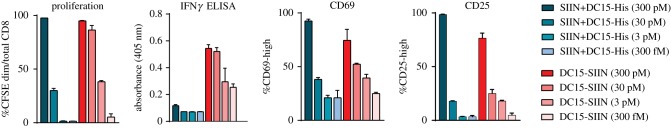
DC15 targeting increases antigen-presentation in vitro. B cells were isolated from mouse spleen by negative selection using CD43 magnetic beads and cultured with agonistic anti-CD40 for 3 days to induce B-cell blasts for use as APCs. APCs were pulsed for 30 min with the indicated concentrations of DC15 either admixed with (blue bars) or directly conjugated to SIINFEKL peptide (red bars). APCs were then washed to remove any unbound or non-internalized antigen and cocultured with CFSE-labelled OT-I T cells. Proliferation was measured by flow cytometry after 72 h. IFNγ was measured by ELISA of 72 h culture supernatants. CD69 and CD25 were measured by flow cytometry at 24 h from replicate cultures. Representative of three independent experiments. Error bars are s.e.m.